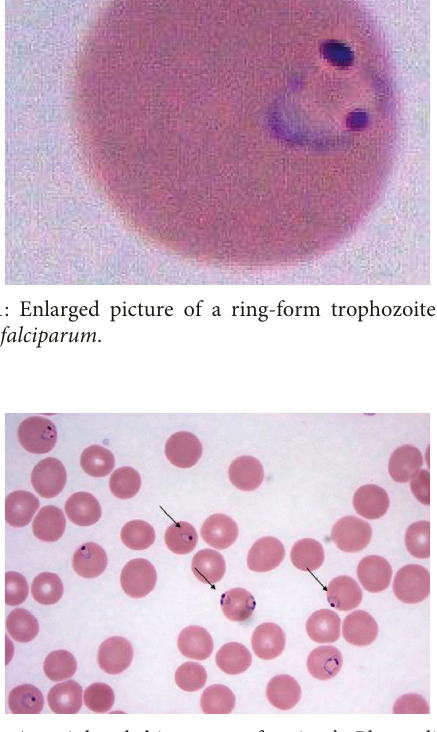
Figure 2: A peripheral thin smear of patient’s Plasmodium falci- parum parasites at admission as indicated by arrows. Slide prepared using Wright stain at 100X magnification.